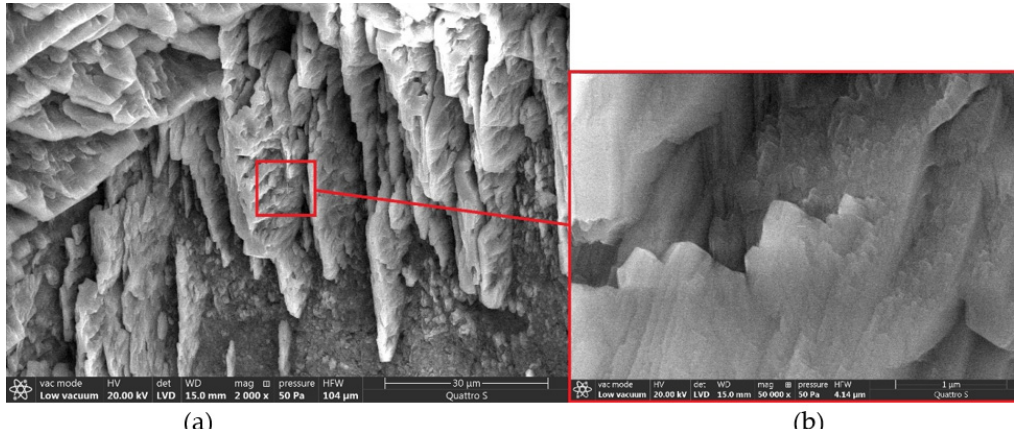
Figure 11. Microstructure of calcium hydroxide on the pore surface in the modified cement matrix of optimal composition at different magnifications: ( a ) ‐ 2000( b ) ‐ 50000. at different magnifications: ( a )—2000, ( b